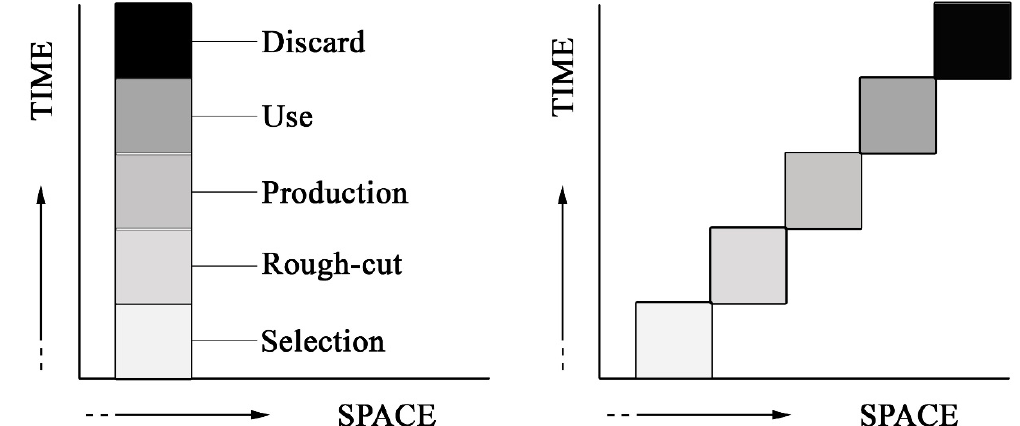
Figure 3. Spatial and temporal extreme strategies of the organisation of technology. The archaeological record usually shows a mix between these two opposite options depending on the technological costs, mobility of the group, and risk associated with the different phases of the productive sequence. Each phase symbolised here could have been realised by a single event or be split into several technical events.